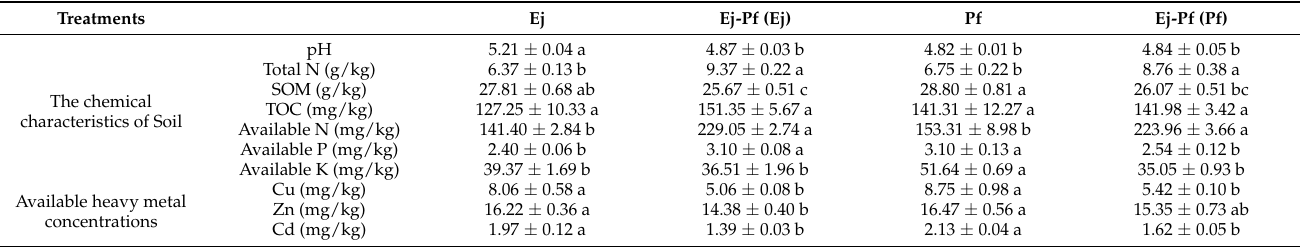
Table 3. The soil chemical characteristics and heavy metal concentrations in the rhizosphere soil of P. × fraseri and E. japonicus in different planting